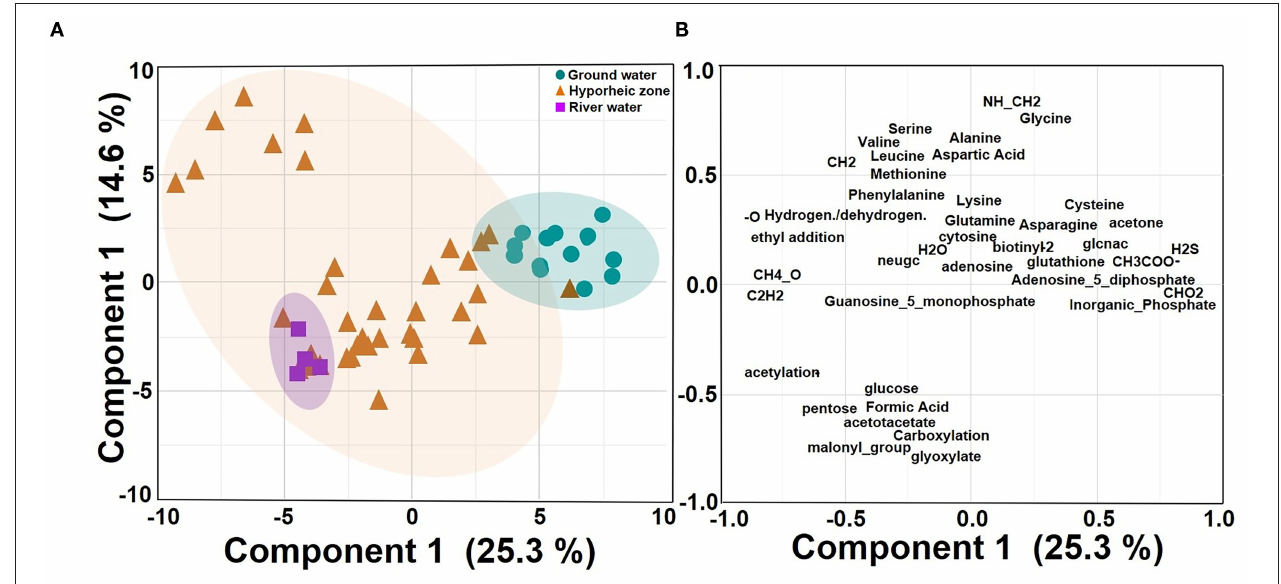
FIGURE 5 | Principle component analysis (PCA) on centered log ratio (CLR) transformed putative chemical transformation abundances in each system (ground water, hyporheic zone, and river water) from the four-time intervals (A–D) (i.e., different river level stages) and piezometer locations in November 2013; (A) Score plot (B) Loading plot. Shaded circles represent 95% confidence